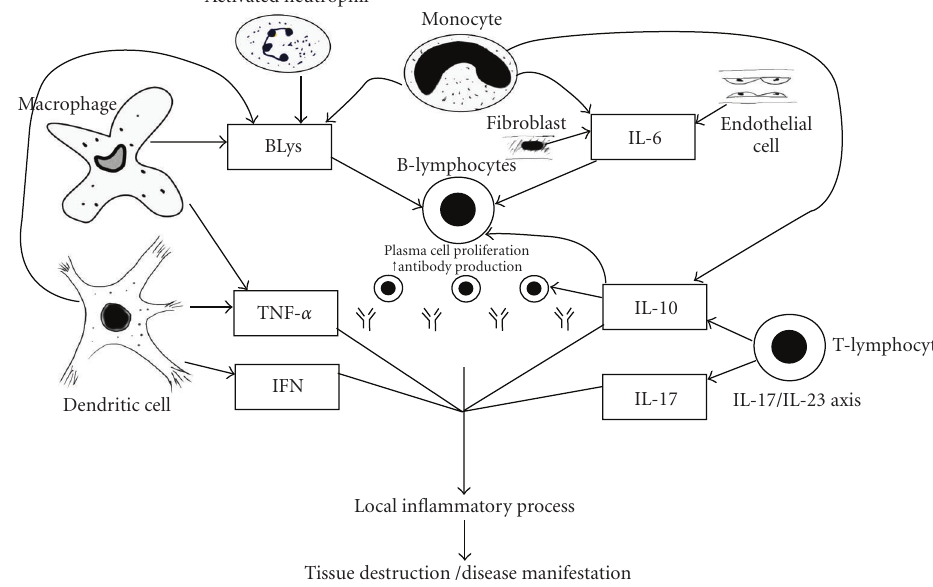
Figure 1: Schematic diagram to show the complex interaction between various immune cells and cytokines which lead to the pathogenesis of